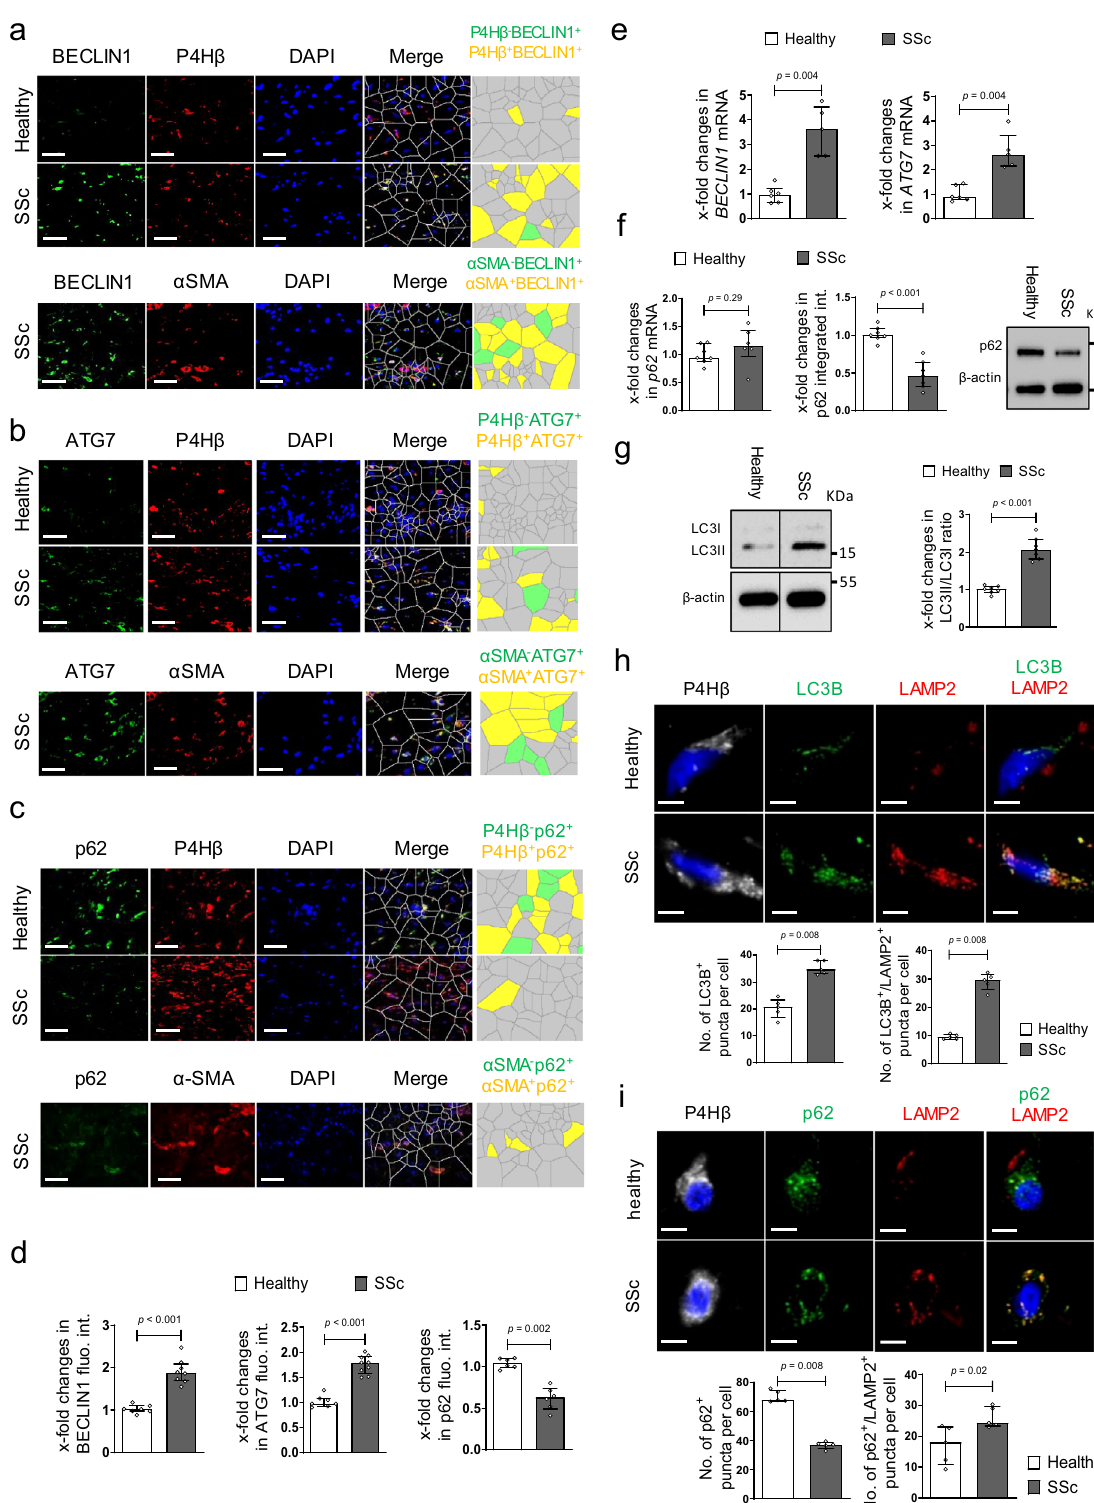
LAMP2 and p62 with LAMP2 and the fi broblast marker P4H β in skin sections with subsequent confocal microscopy and semi- automated quanti fi cation. LC3B-positive puncta were increased in fi broblasts in SSc skin compared to healthy individuals (Fig. 1h). We observed comparable increases of LC3B puncta in murine models of SSc (Supplementary Figs. 2e, f and 3b, c). Most of the LC3B-positive puncta co-localized with the lysosomal